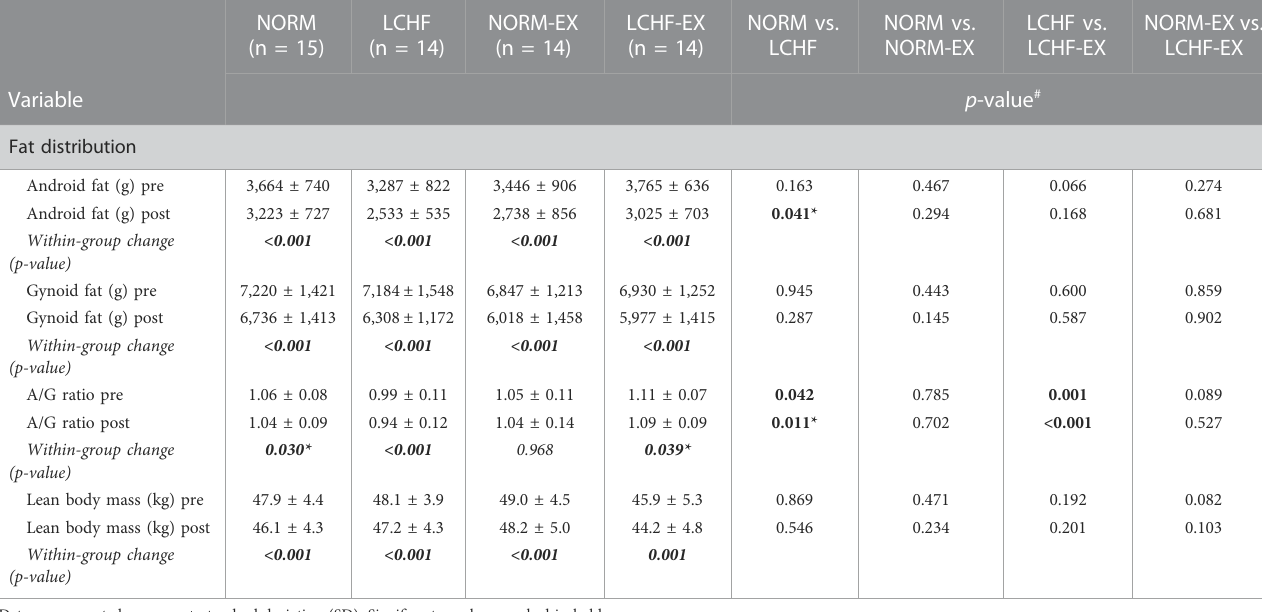
TABLE 4 Secondary outcomes: Android fat, gynoid fat, and lean body mass at baseline and after the 10-week